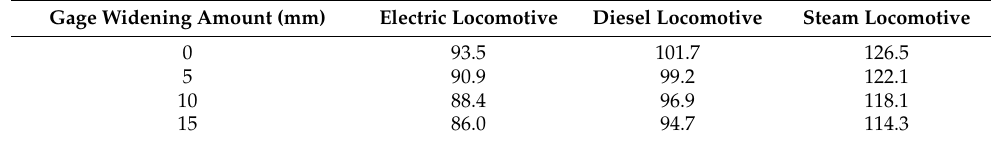
Table 14. Minimum curve radii (m) that a locomotive can pass through with normal forced inscribing.